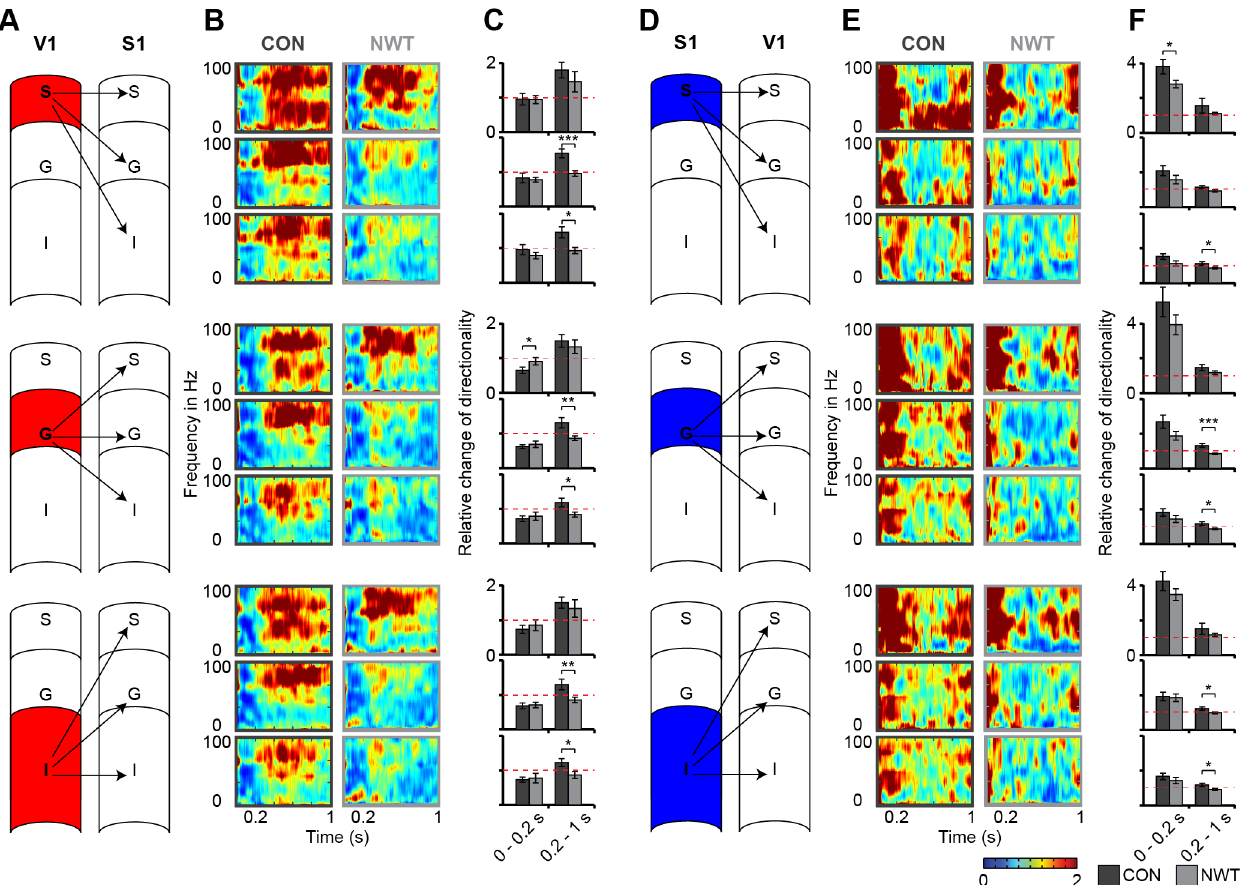
Fig 6. Directed interactions between S1 and V1 in CON and NWT rats. ( A ) Schematic representation of the analyzed direction of interaction from V1 to S1 layers. ( B ) Time- and frequency-resolved color-coded plots of Granger causality for cross-modal interactions of S (top), G (middle), and I (bottom) layers of the V1 with all S1 layers of CON (left) and NWT rats (right). The panels correspond to the interactions between different layers displayed in (A). In all panels, an increased drive compared to baseline (pre-stimulus) is encoded in red, whereas a decreased drive is encoded in blue. ( C ) Bar diagrams displaying the relative changes of directionality between V1 and S1 of CON (black) and NWT rats (gray) when averaged for the first 200 ms and the subsequent 800 ms after stimulus. Red dashed lines indicate the level of baseline causality. Significance values ( p < 0.05 [ * ]) correspond to the comparison between CON and NWT rats. ( D ) Same as (A) for the directed interactions from S1 to V1. ( E ) Same as (B) for the directed interactions from S1 to V1. ( F ) Same as (C) for the directed interactions from S1 to V1. The underlying data of this figure can be found in S1 Data.